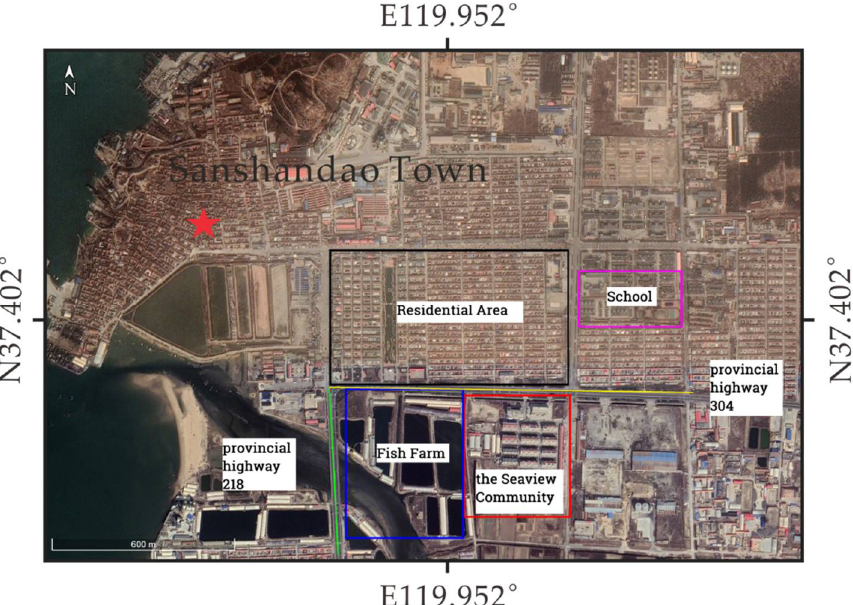
Figure 8. The important constructions and provincial highways (marked with lines and rectangular wireframes) in mining area.